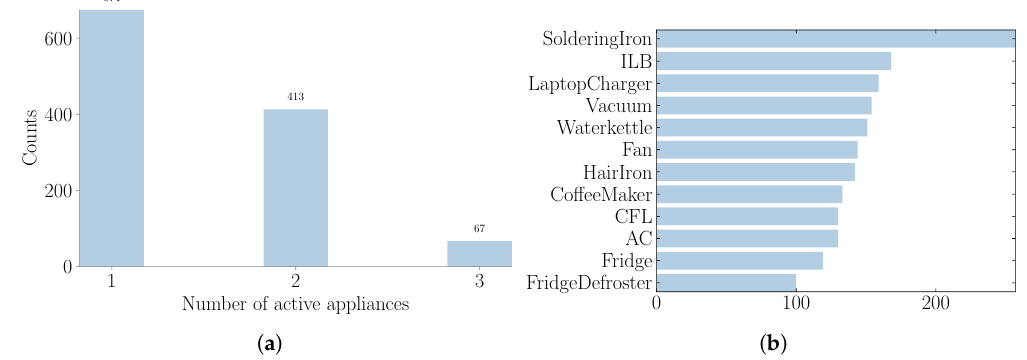
Figure 7. ( a ) Active appliances distributions. ( b ) Appliances distribution on the extracted 1154 activations. The soldering iron has large number of activations because it has two start-up